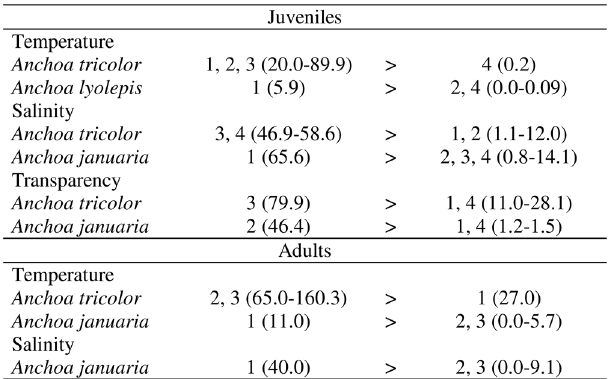
Table 4. Significant differences (p < 0.05) in number of in - dividuals for each species from Engraulidae family, among ranges of environmental variables, according to Student- Newman-Keuls (SNK) test. Mean values in brackets. Envi - ronmental ranges according to Table 3.